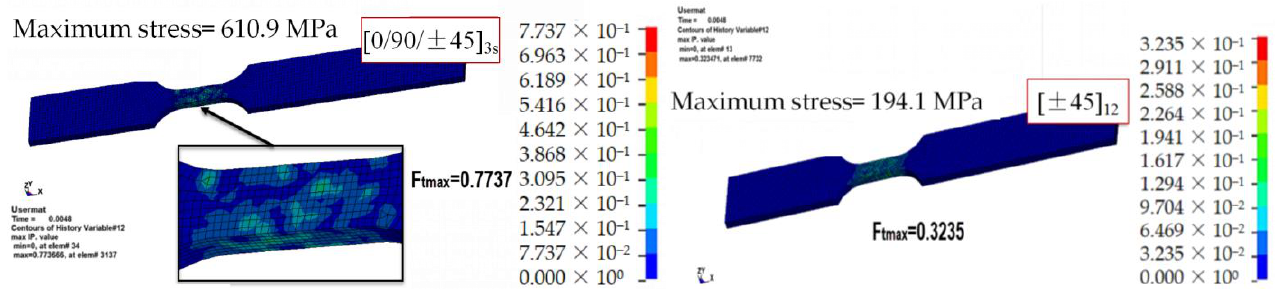
Figure 8. Fiber tensile failure factor contour map of the [0/90/±45] 3s and [±45] 12 specimens tested at a strain rate of 250 s −1 when d = 0.15 mm.